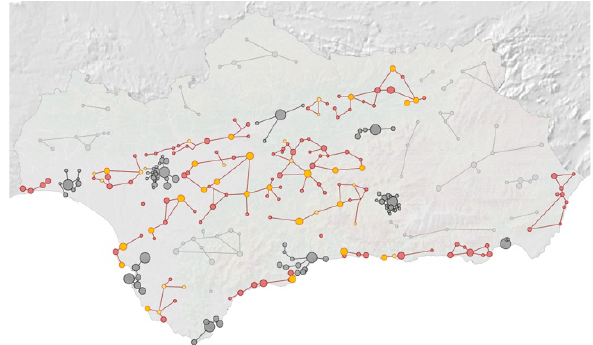
Figure 2. Cities that have been declared as heritage sites (marked in orange) in the urban systems formed by Medium- Sized Cities (The authors, 2018)